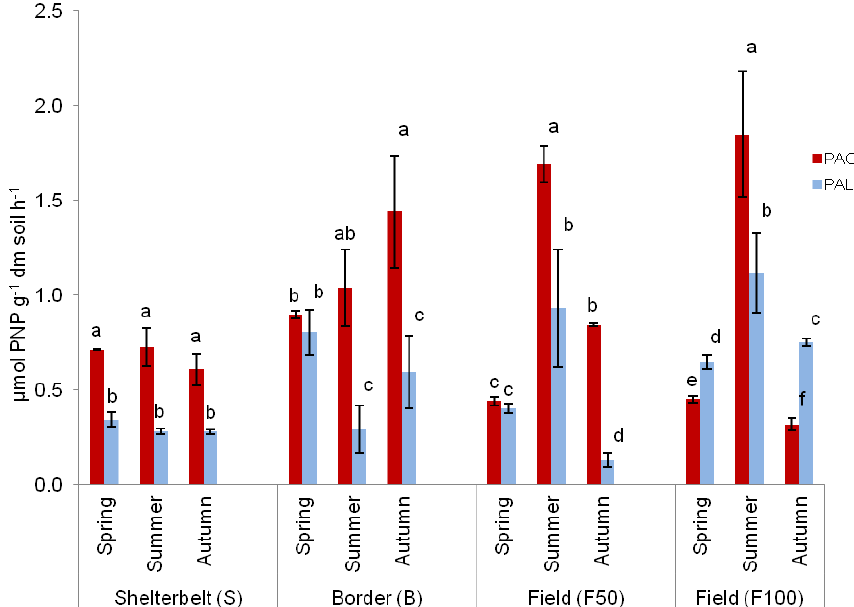
Figure 6. Phosphatase acid (PAC) and alkaline phosphatase (PAL) activity in Luvisols on three research dates (average values ± standard deviation; n = 3). Different letters indicate significant differences; ANOVA carried out separately for measuring point and sampling time, p < 0.05.